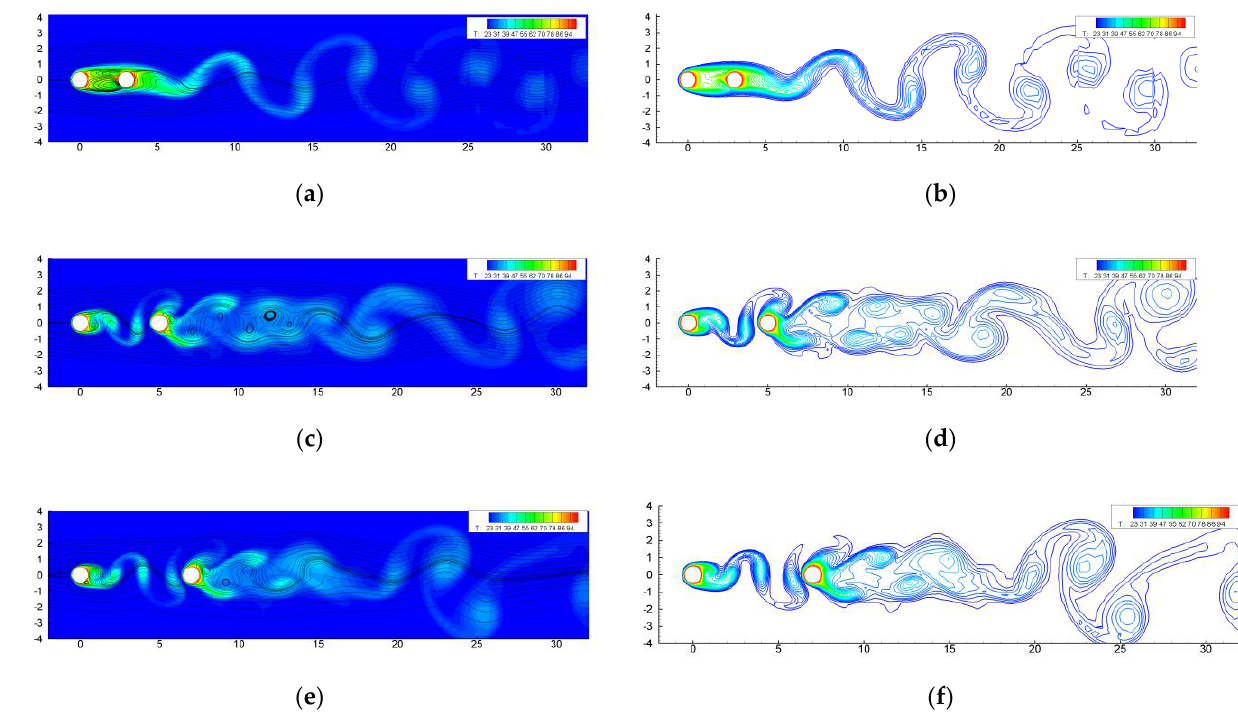
Figure 10. Flow patterns of Re=200, streamlines ( left ) and temperature contours ( right ): ( a , b ) L/D = 3, unstable reattachment; ( c , d ) L/D = 5, co-shedding; ( e , f ) L/D = 7, co-shedding.